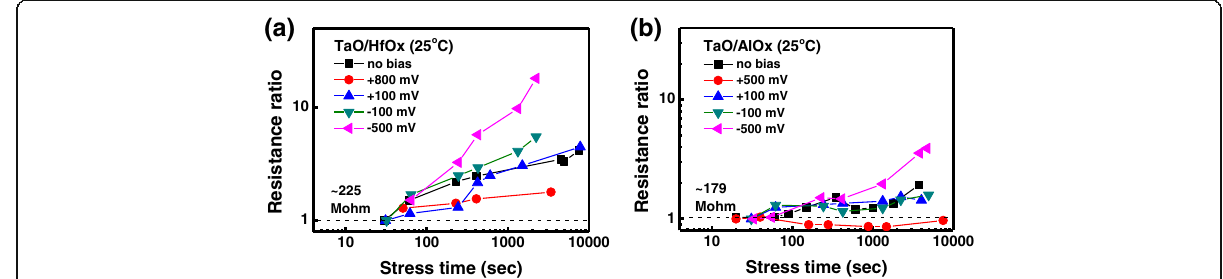
Fig. 5 On-bias resistance ratio versus stress time for a TaO/HfO x and b TaO/AlO x devices at room